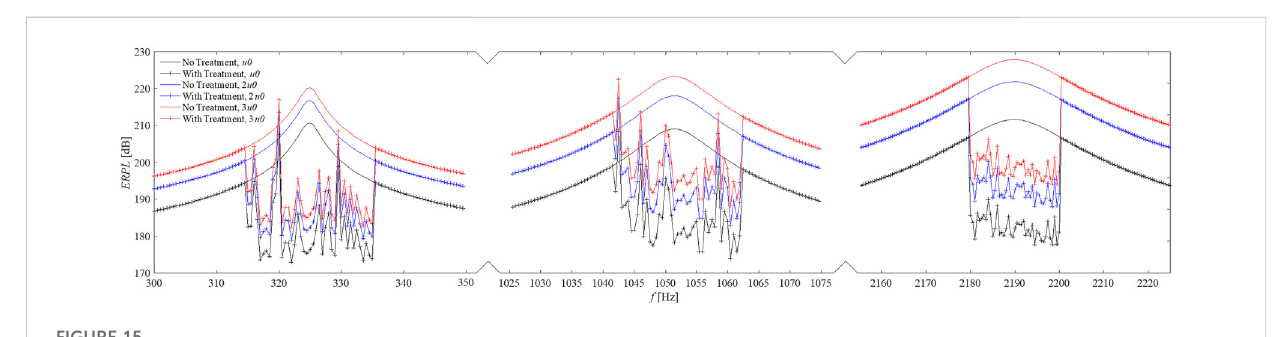
FIGURE 15 ERPL frequency response with different excitation